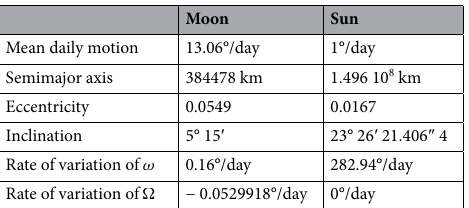
Table 1. The orbital elements ( M , a , e , i ) and the rates of variations of (ω , �) of Moon and